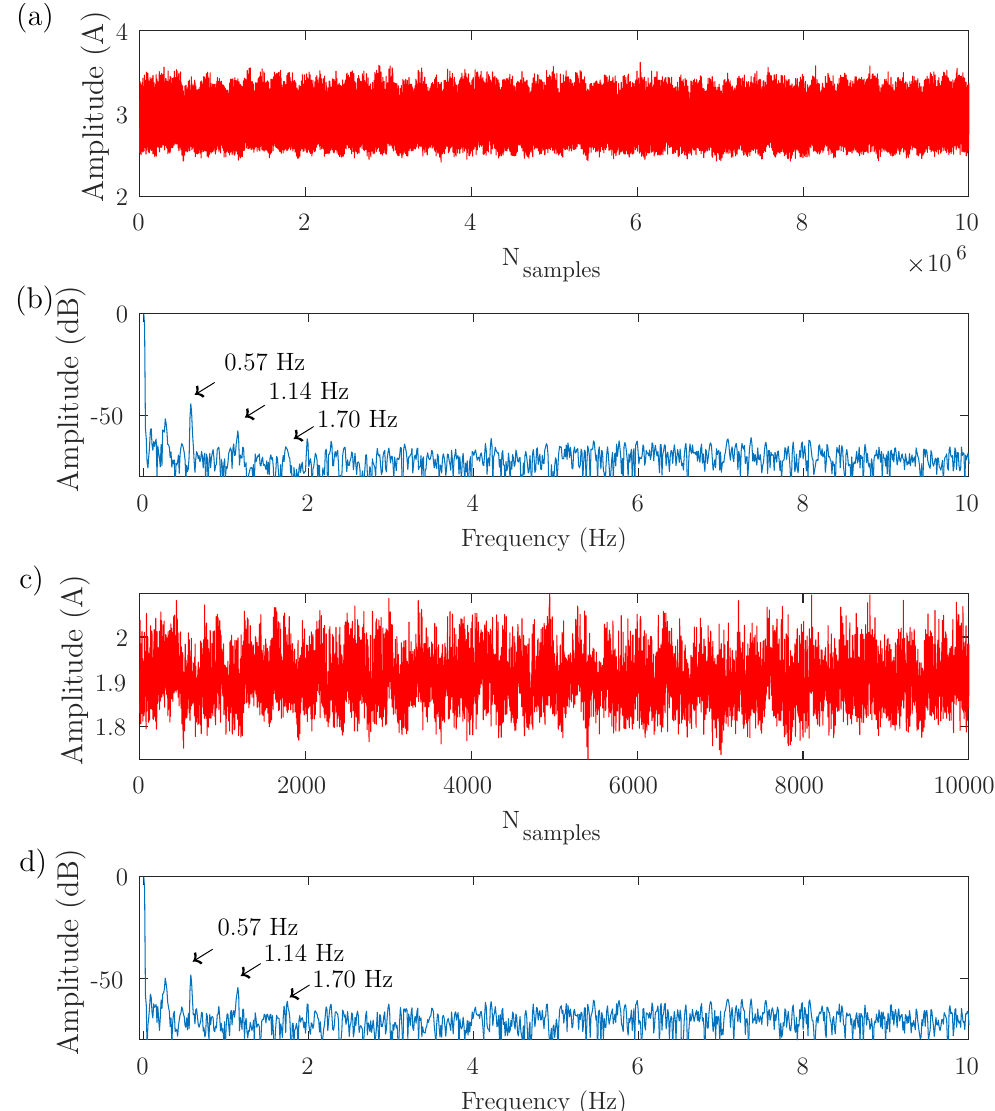
Figure 4. Test 1. Motor fed through the ABB VSD in V/Hz control mode, a reference speed of 3000 r/min, and without any load (speed = 2983 r/min, slip = 0.0057 p.u.). ( a ) Full-length current envelope (10 7 samples) and its spectrum ( b ), showing the three first fault harmonics. ( c ) Reduced current envelope (10,000 samples), and its spectrum ( d ). Both spectra show the same fault harmonics, although the reduced current envelope contains only the 0.1% of the original number of